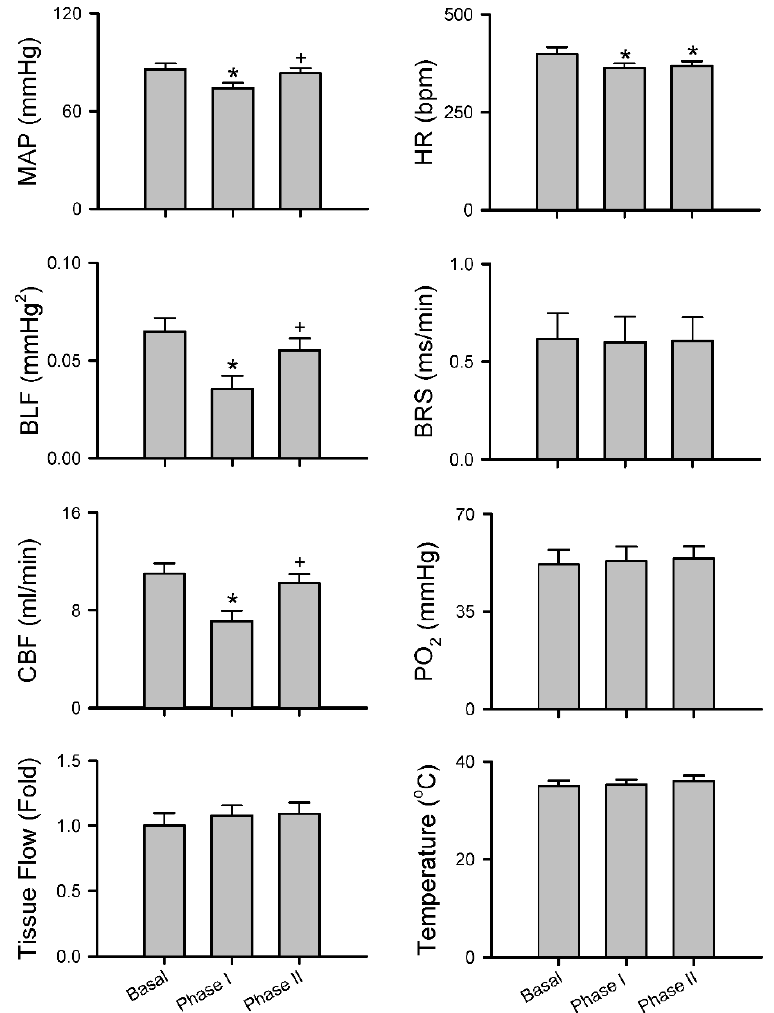
Figure 4. Common response patterns of MAP, HR, BLF, BRS and CBF or tissue perfusion, PO 2 or temperature in the cerebral cortex to intrathecal administration of 80 μL of bupivacaine. Note that values for MAP, HR, BLF and BRS are mean ± SEM of 33 animals (17 from Group 2 plus 16 from Group 3); values for CBF are mean ± SEM of 17 animals from Group 2; and values for tissue perfusion PO 2 or temperature in the cerebral cortex are mean ± SEM of 16 animals from Group 3. * p < 0.05 versus data obtained under basal conditions in the post hoc Dunnett multiple-range analysis; + p < 0.05 versus data obtained during Phase I in the post hoc Tukey multiple-range analysis.